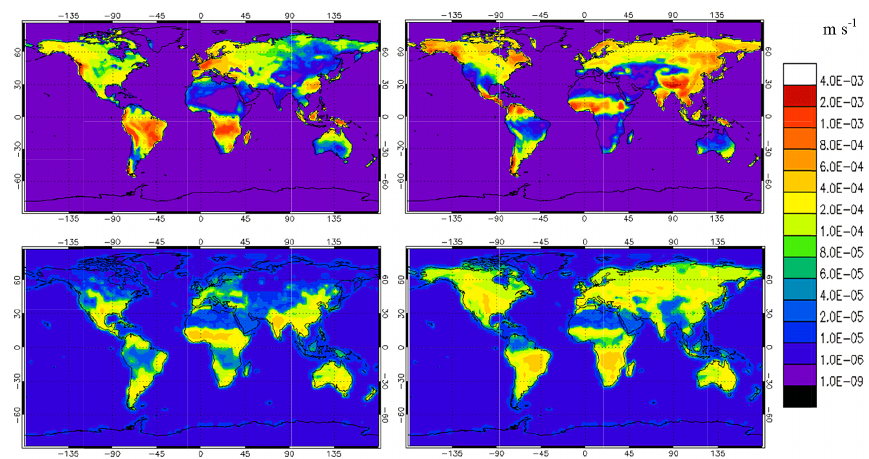
Figure 2. Monthly mean dry deposition velocities in metres per second for January (left) and July (right). Top panels: data derived with the ECHAM5/MOZ parameterization, bottom panels: data derived with the parameterization from Sanderson et al.